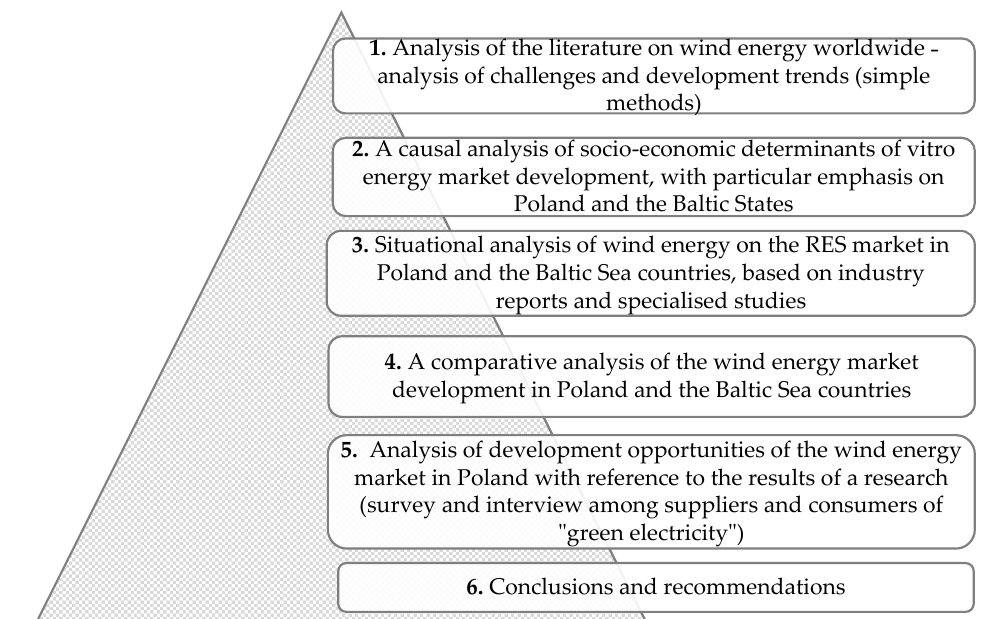
Figure 1. Research algorithm.